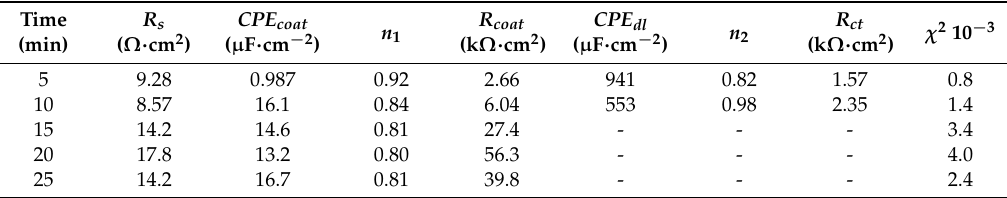
Table 3. The fitting results of EIS shown in Figure